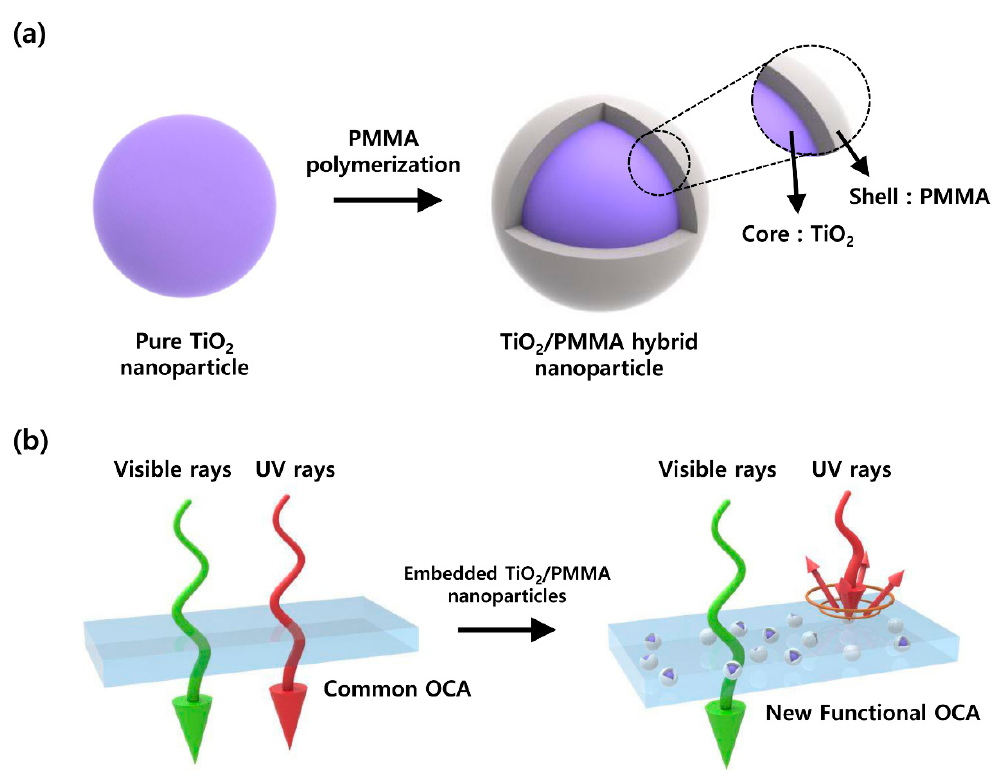
Figure 1. ( a ) Structure of inorganic–organic TiO 2 / PMMA hybrid nanoparticles. ( b ) Schematic of selectively UV-blocking and visibly transparent adhesive films.